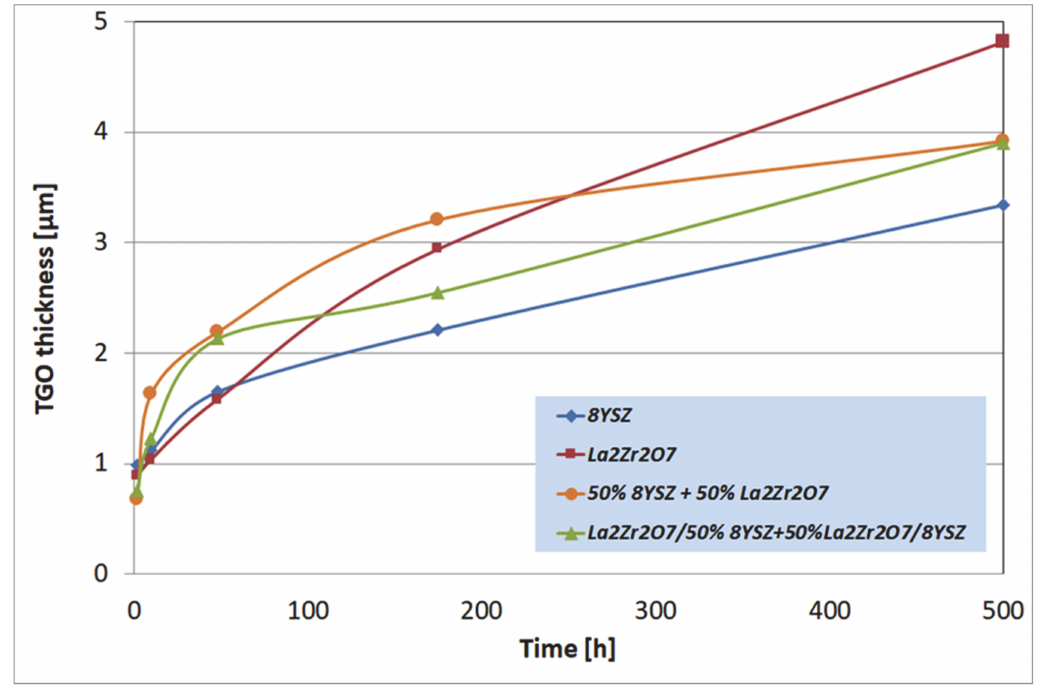
Figure 10. The thickness of the thermally grown oxide (TGO) zone as a function of oxidation